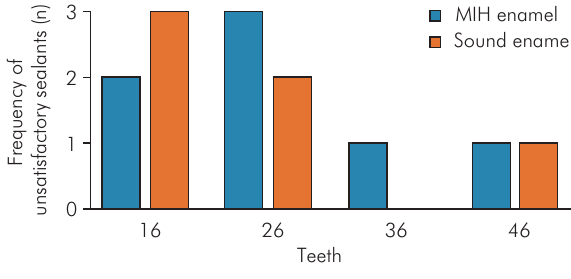
Figure 4. Frequency of unsatisfactory sealants according to the type of tooth in each group after 18 months of